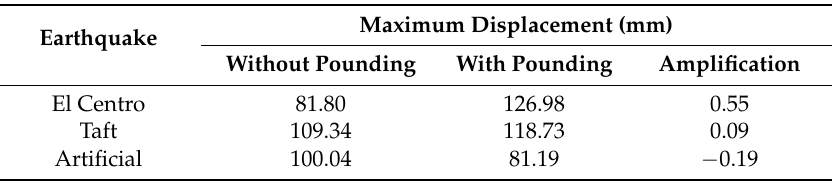
Table 9. Maximum structural displacements for model B.